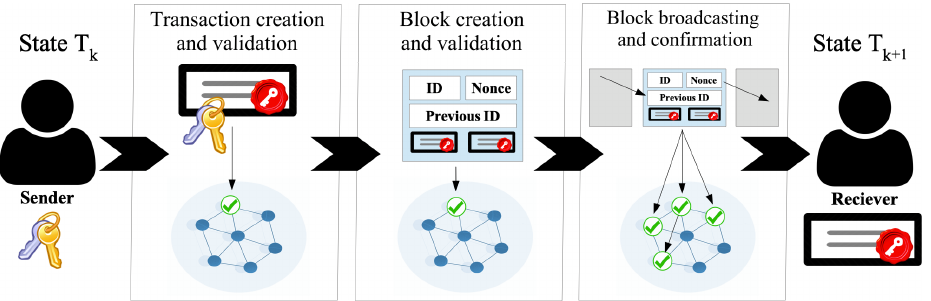
Figure 1. Block scheme of the blockchain protocol for creating and validating a transaction, creating and validating a block, and broadcasting the block in the network from an agreed state in T k to an agreed state in T k + 1